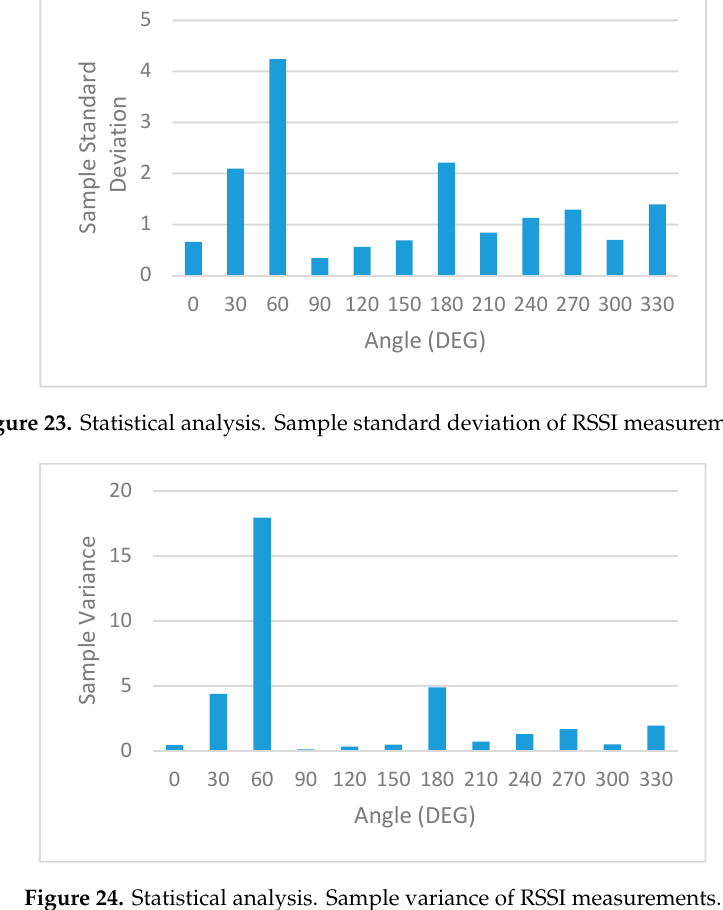
Figure 25. Statistical analysis. Coefficient of variation of RSSI measurements. Both accuracy and reliability of the measurements during the experiments are validated using the coefficient of variation (CV) pictured in Figure 25. Given the low dispersion during these